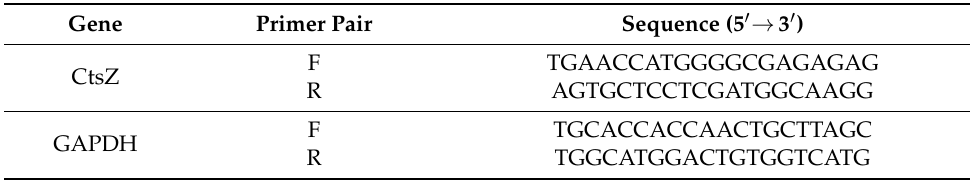
Table 1. Primer pair sequences for